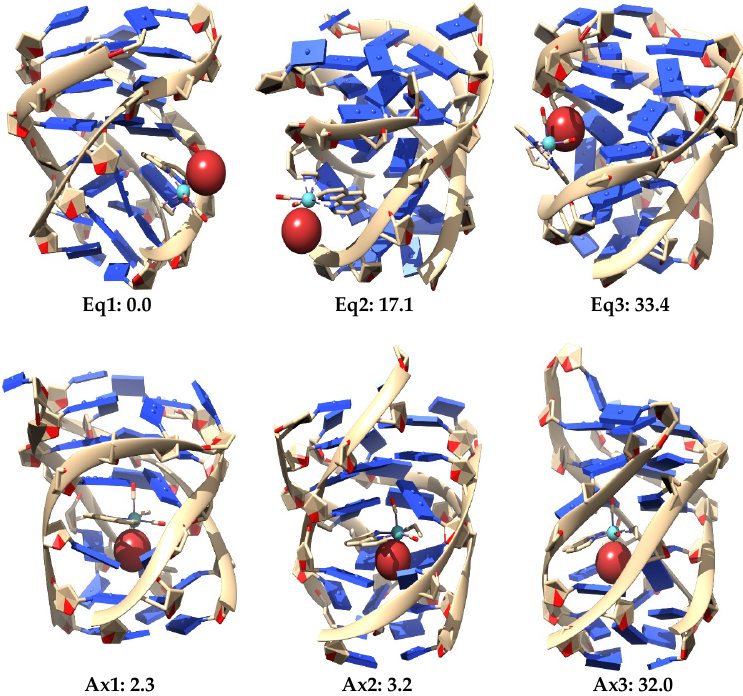
Figure 30. Three most stable optimized structures for the interaction of the Eq ( top ) and Ax ( bottom ) isomers of the [Mo( η 3 -C 3 H 5 )Br(CO) 2 (phen)] interacting with the studied DNA GQ at LMKLL/DZ2P level of theory. Relative energies in kcal mol − 1 .